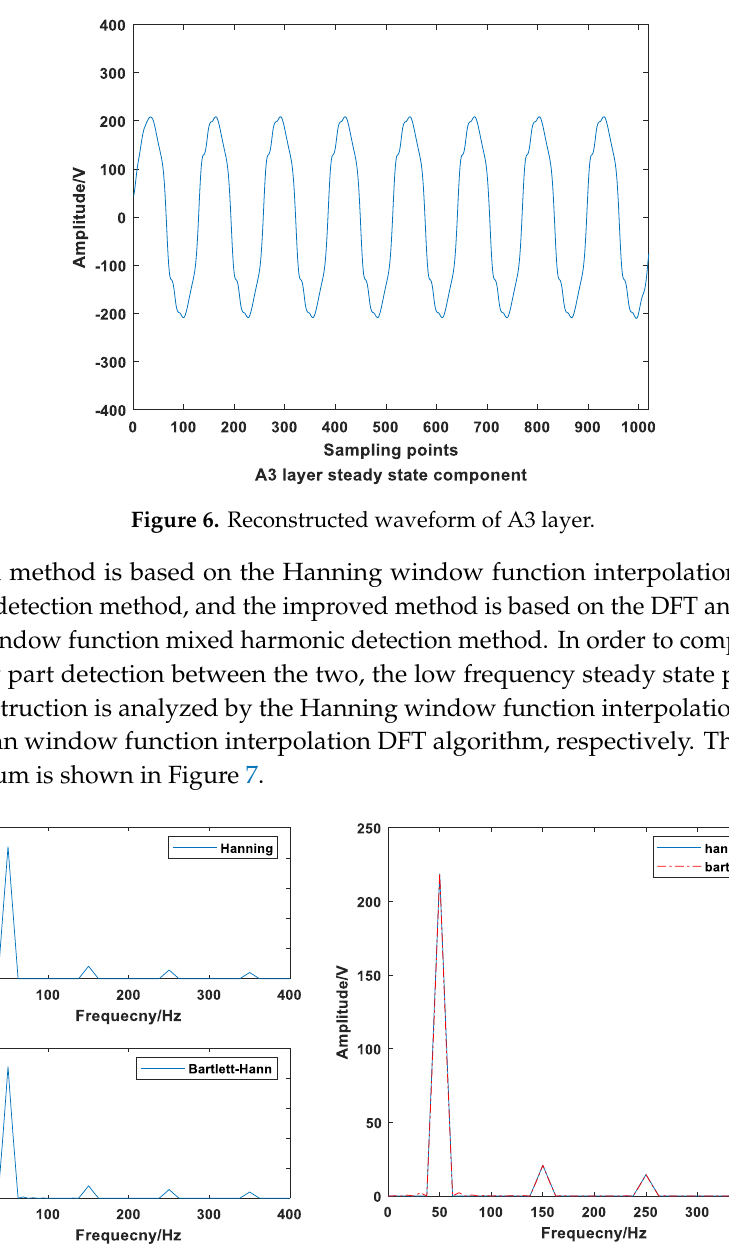
Figure 7. A3 layer windowed interpolation DFT spectrum comparison chart.